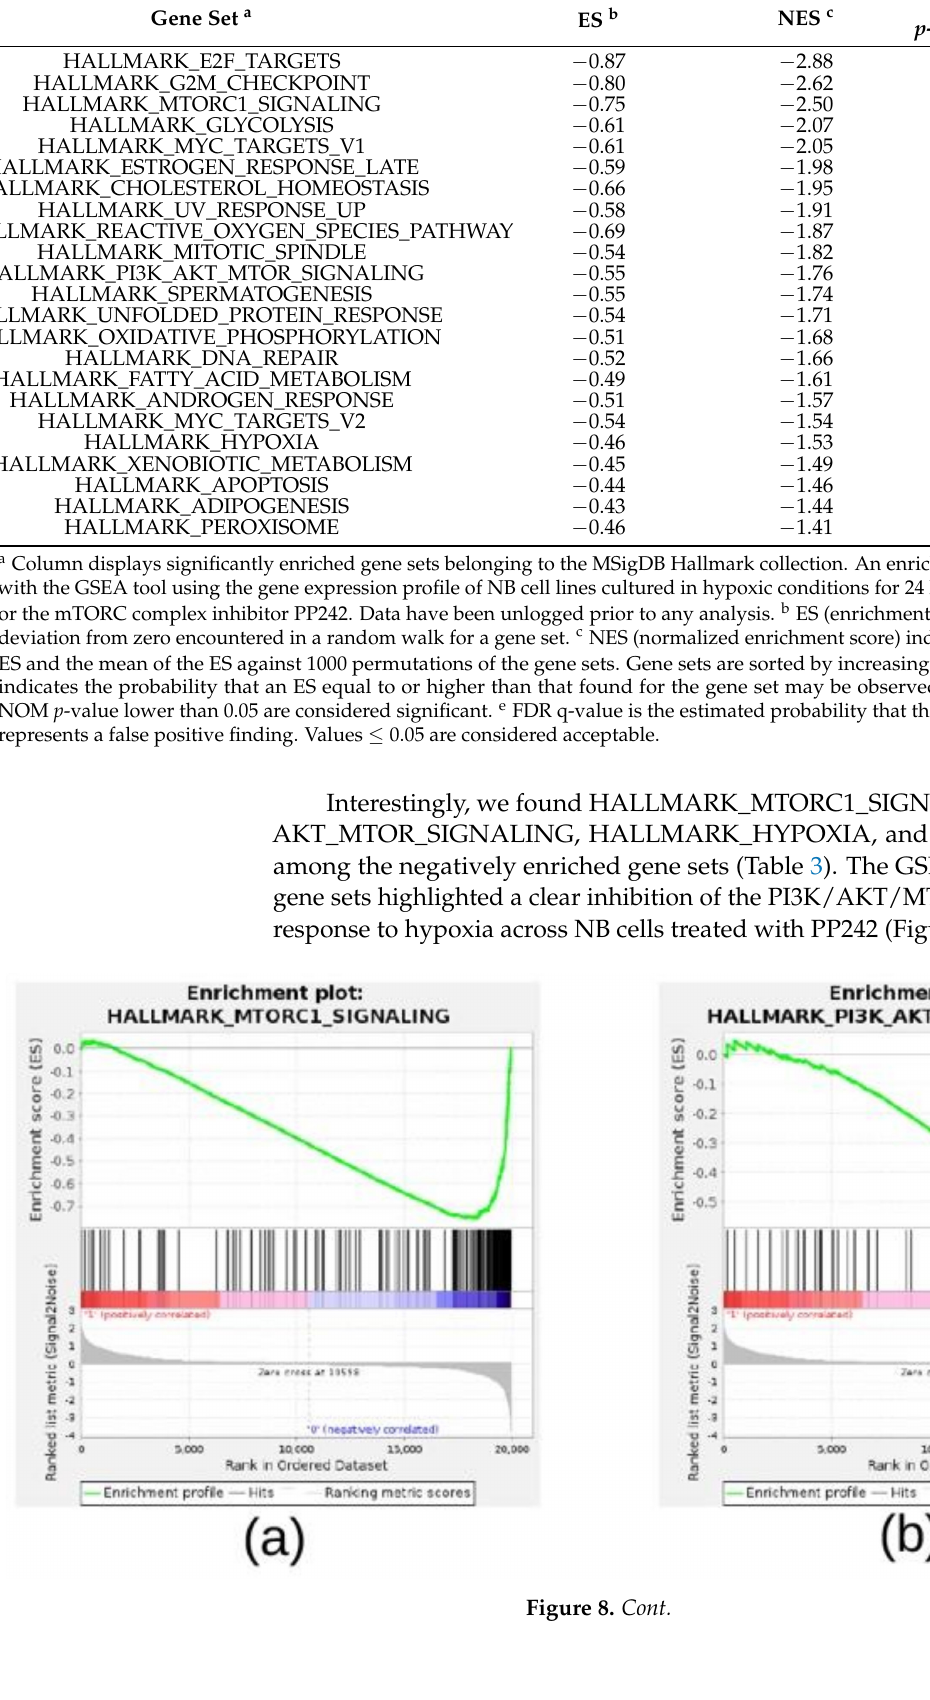
Table 3. Hallmark gene sets enriched in NB cell lines treated for 24h with the mTORC inhibitor. Gene Set a ES b NES c